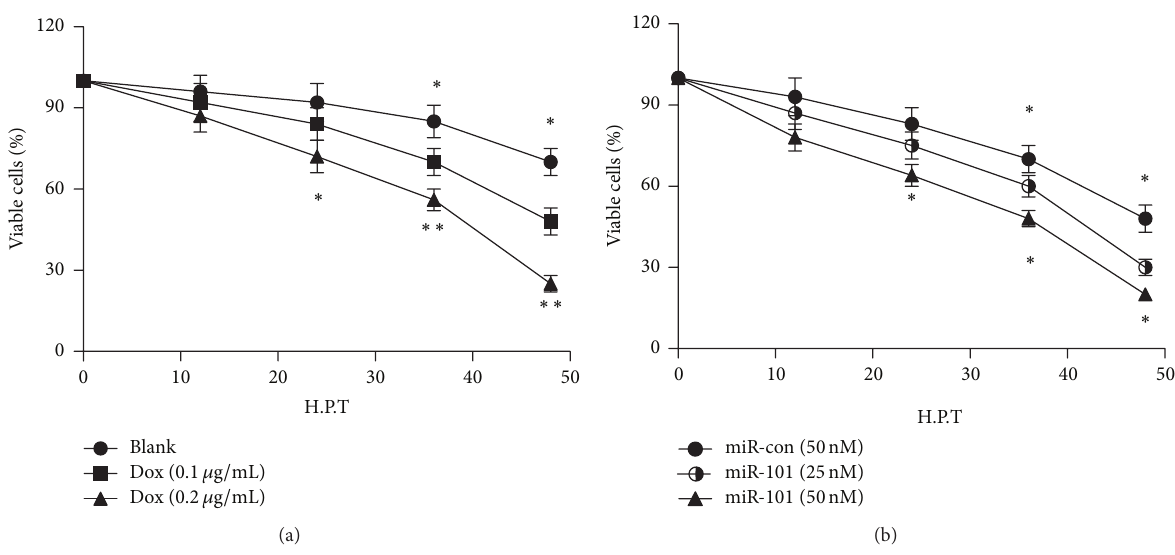
Figure 5: MiR-101 deteriorates the Dox-induced cell viability reduction. (a) Viability of U-2 cells after Dox treatment with 0, 0.1, or 0.2 𝜇 g/mL. (b) Viability of U-2 cells after 0.1 𝜇 g/mL Dox treatment and the transfection with 25 or 50 nM miR-101 mimics or 50 nM miR control ( ∗ 𝑃 < 0.05 ; ∗∗ 𝑃 < 0.01 ). All results were from three independently performed experiments.